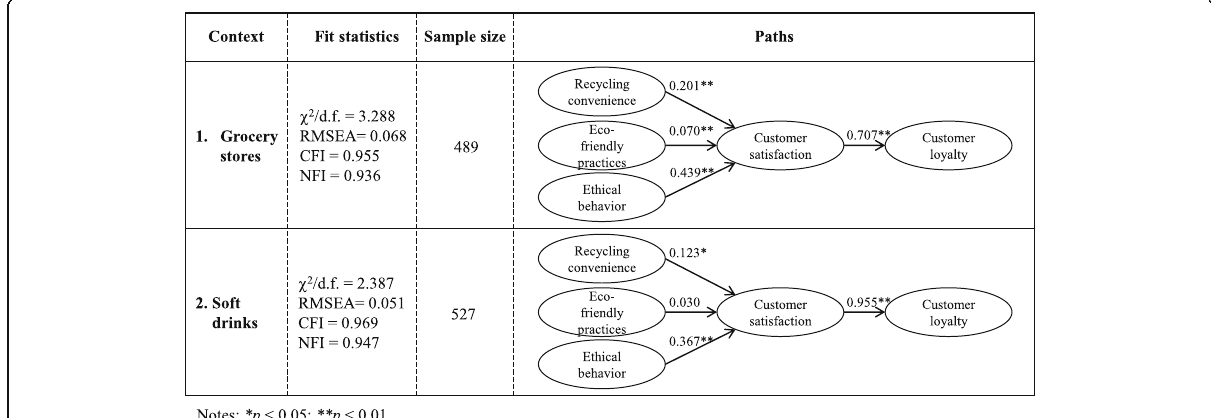
Fig. 2 Results of structural models for grocery stores and soft